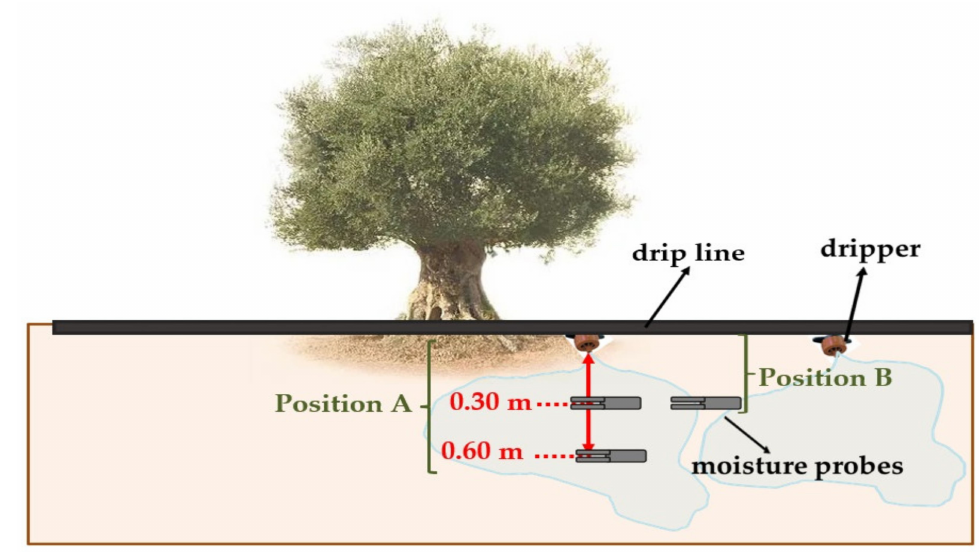
Figure 2. Sensor